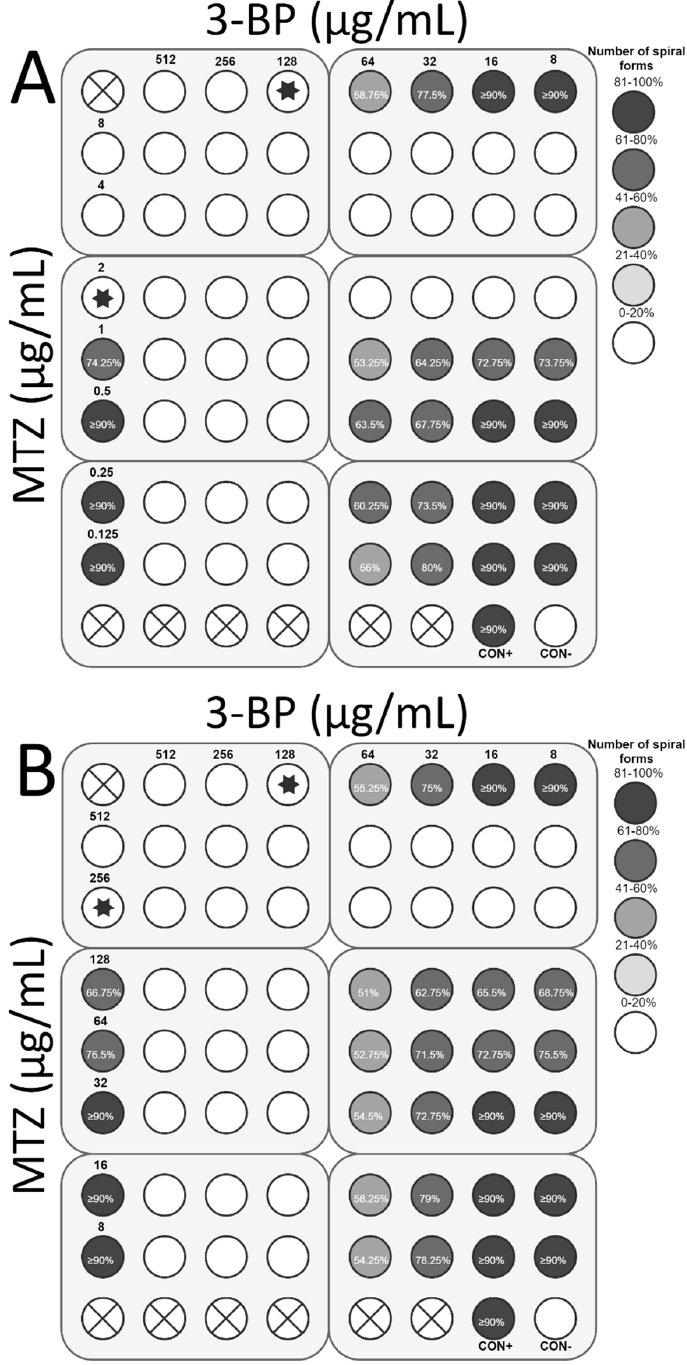
Figure 11. The antibacterial and morphological effects of 3-Bromopyruvate (3-BP), metronidazole (MTZ), and combinations of both against H. pylori Tx30a and 7143 strains. The existence of the interaction in the antimicrobial activity of 3-BP with MTZ was determined against ( A ) the reference antibiotic-susceptible H. pylori Tx30a and ( B ) the clinical double-resistant H. pylori 7143 strain. The white circles indicate the wells in which the number of spiral forms was ≤ 15%, while the white circles with a cross in the middle indicate empty wells. Using asterisks, the wells with the MICs of the tested substances were marked, whereas in the case of the interaction verifications, they indicate the lowest FIC. Abbreviations: 3-BP, 3-Bromopyruvate; MTZ, Metronidazole; CON+, Positive control; and CON − , Negative control.